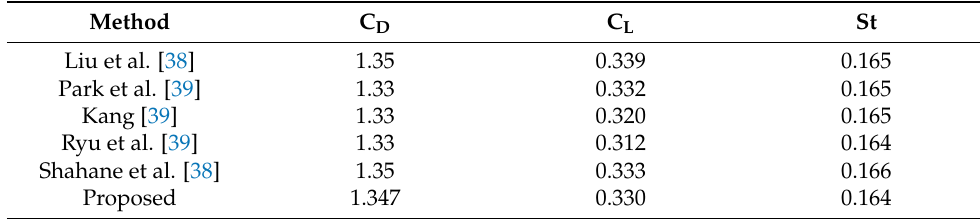
Table 3. Comparison of drag and lift coefficients and Strouhal number ( Re = 100).